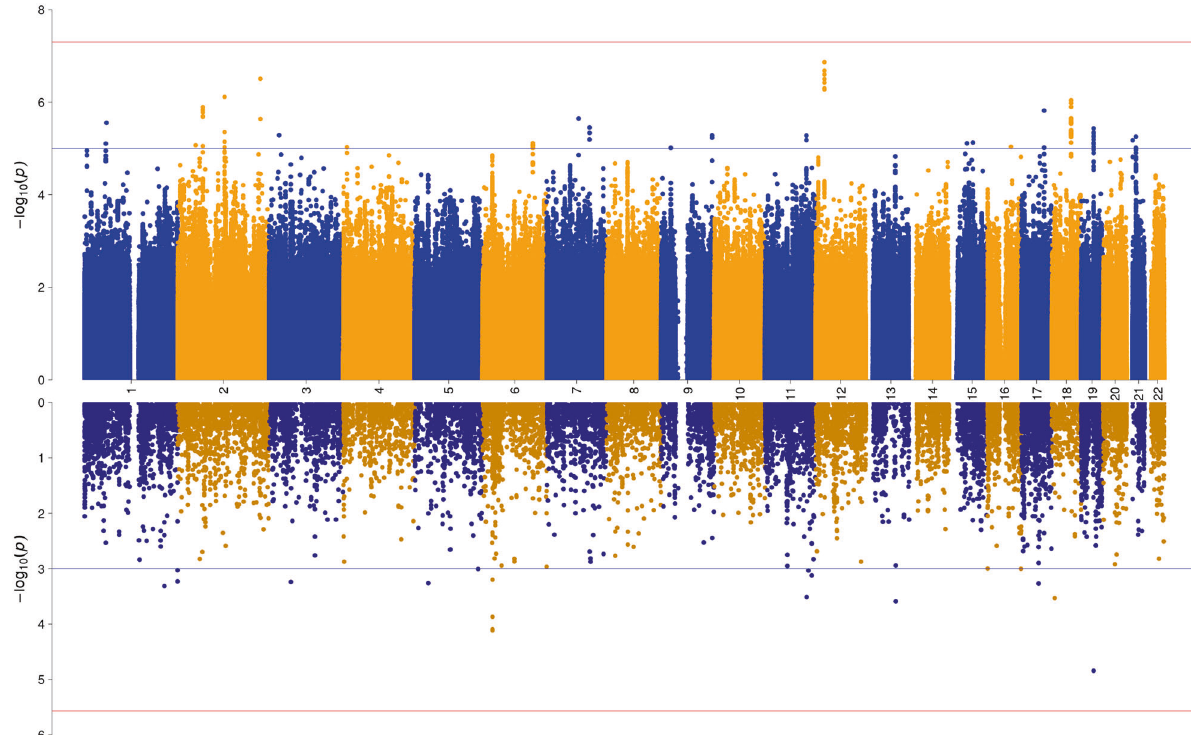
Fig. 1 Miami plot of the association results from the GWAS meta-analysis (upper panel) and of the gene-wide association analysis (lower panel) of HS. The y -axes represent − log10 P values for the association of SNPs/genes with HS. The x -axis represents chromosomes 1 to 22. In the upper plot, the P -value threshold for genome-wide signi fi cance (5 × 10 – 08 ) is represented by the horizontal red line, suggestive signi fi cance ( p = 1 × 10 – 05 ) by the blue line. In the lower panel, Bonferroni-corrected gene-wide signi fi cance ( p = 2.682 × 10 – 06 ) is represented by the horizontal red line, suggestive gene-wide signi fi cance ( p = 1 × 10 – 03 ) is indicated by the blue horizontal